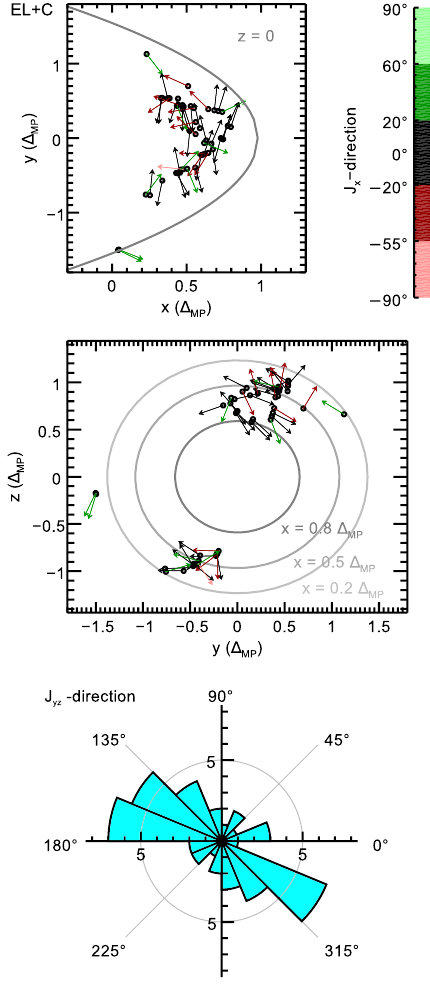
Figure 9. Same as Fig. 8 but for EL + C